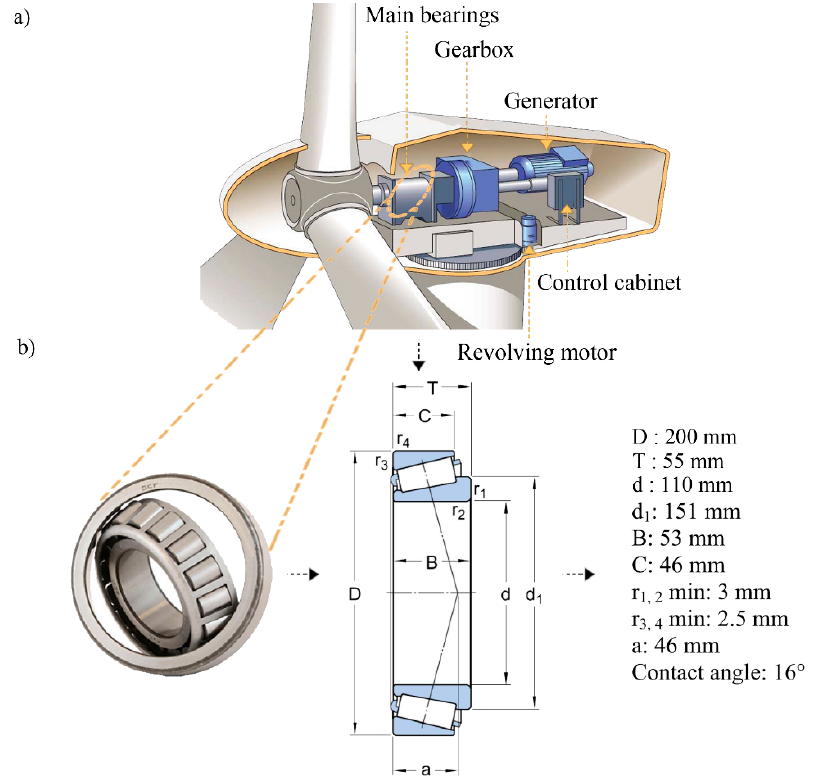
Figure 3. ( a ) Position of the main bearings in a wind turbine. ( b ) Studied bearing type and its di- mensions.